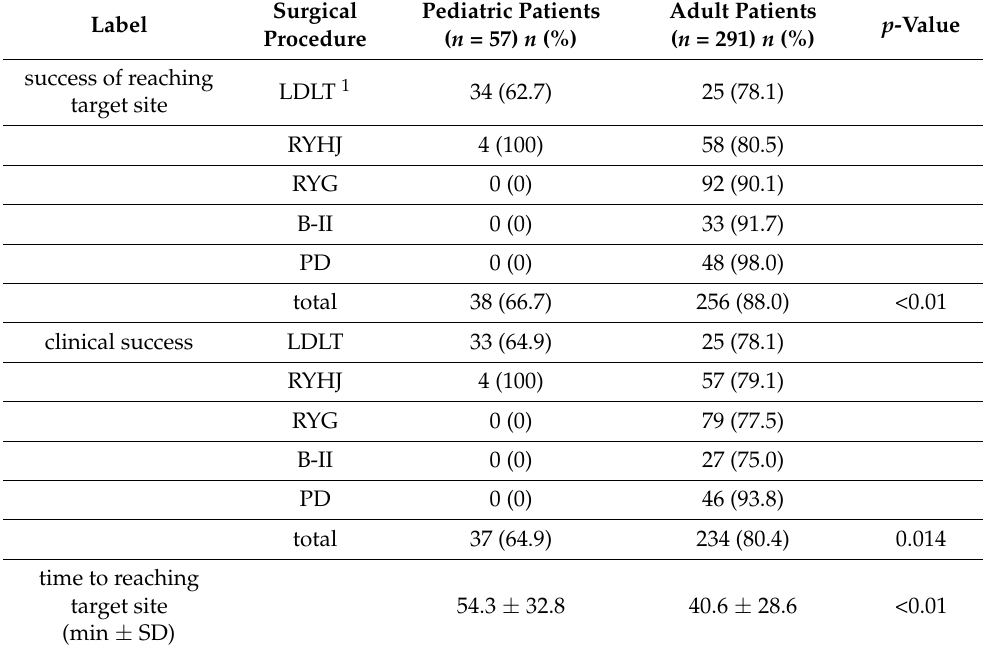
Table 3. BEA-ERC for patients with surgically altered